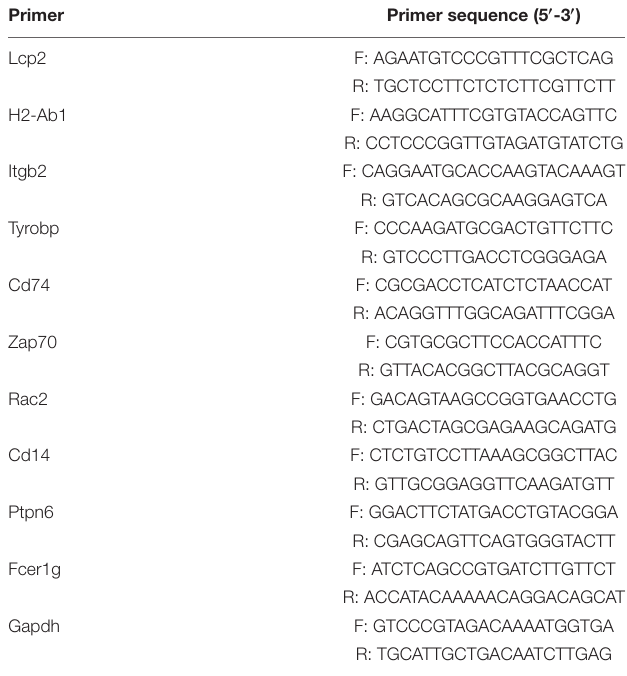
TABLE 1 | The sequences of primers used in quantitative real-time PCR.